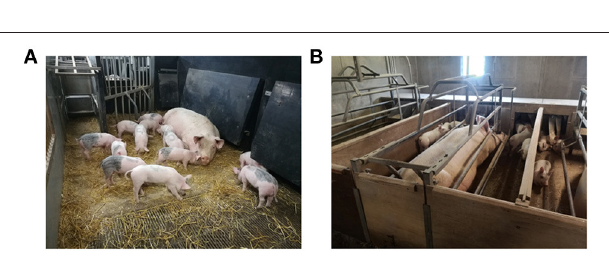
FIGURE 2 | (A) PigSAFE Pen with sow and litter during lactation. (B) Farrowing Crate with sow and litter during